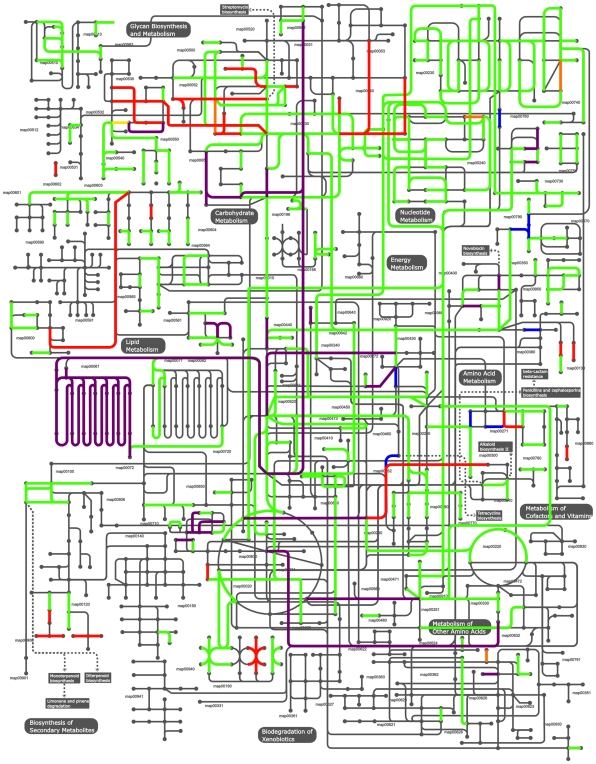
Metabolic potential.The metabolic pathways of G. vaginalis were mapped based upon genome information using iPath. Common pathways are shown (green), along with those specific to strain 409-05 (blue), 317 (orange) and 594 (yellow). Those pathways common to the two BV-isolates are shown in red, while those common to strain 409-05 and 317 are shown in purple. No enzymes were exclusively found in 409-05 and 594.